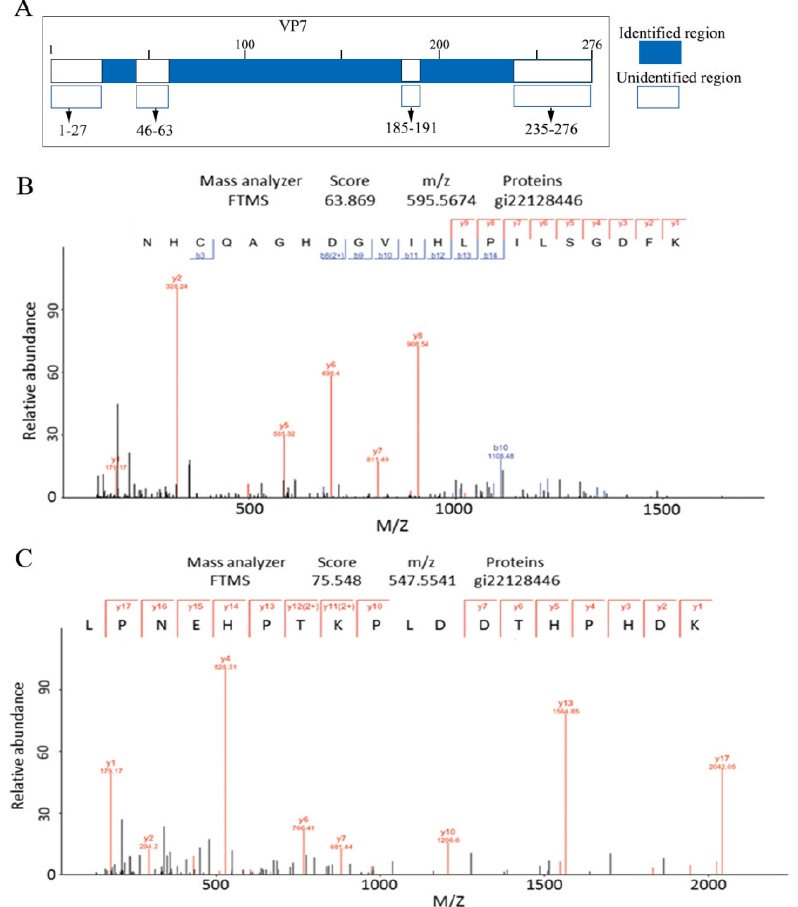
Figure 4. Identification of the GCRV VP7 tryptic peptide using LC-MS/MS. ( A ) Diagrammatic representation of tryptic fragments of VP7. The fragments accounted for 182 of the 276 predicted amino acids in VP7 (66% coverage). ( B , C ) LC-MS/MS spectra of two cleaved VP7 peptide fragments using tryptic in-gel digestion. GCRV, grass carp reovirus; LC-MS/MS, liquid chromatography-tandem mass spectrometry.